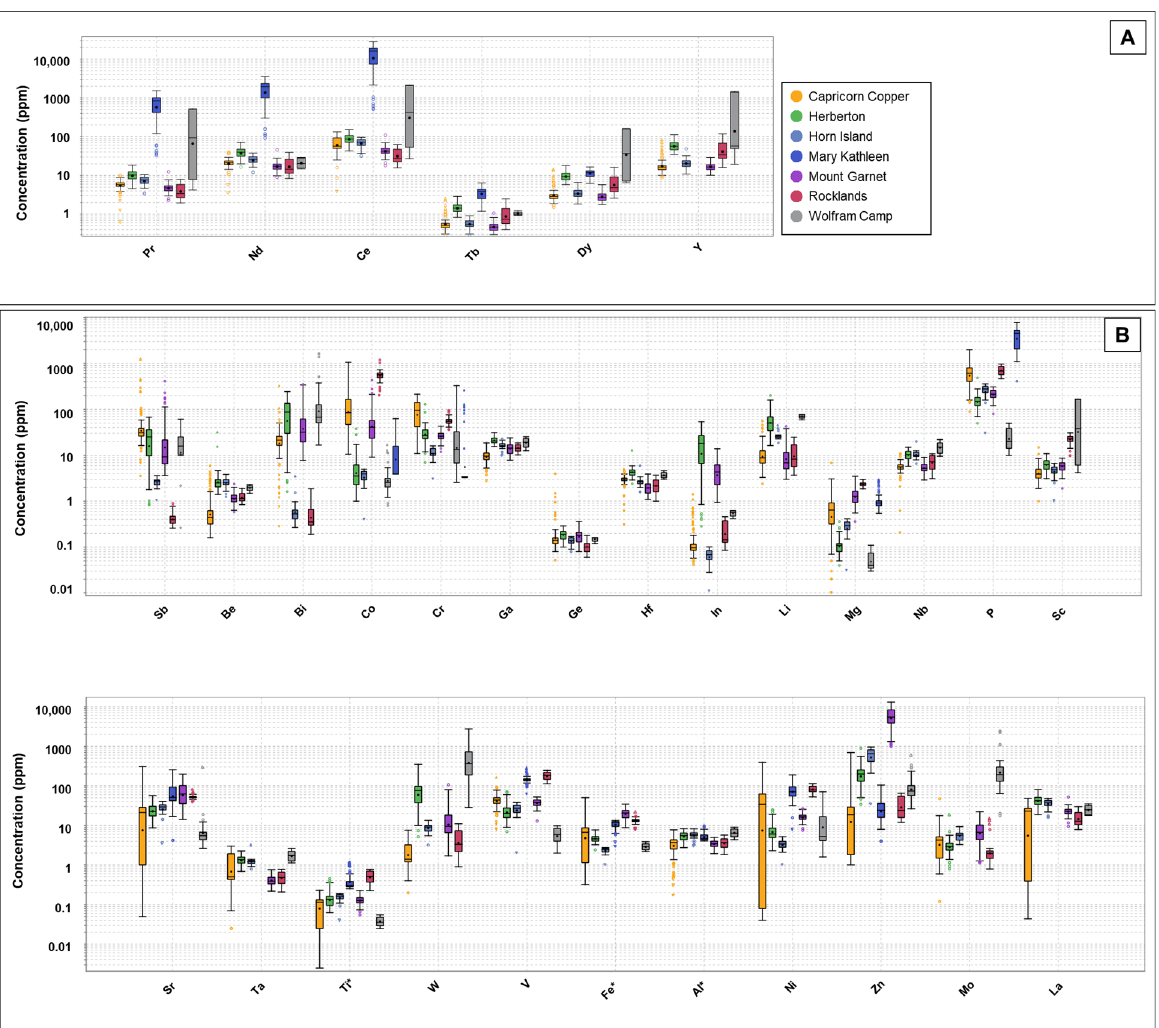
Figure 5. Tukey log-plot graph showing the concentration of the critical elements at each deposit included in Australia split in ( A ) REEs-Praseodymium, Neodymium, Cerium, Terbium, Dysprosium and Yttrium ( B ) other critical elements. All concentrations in ppm except Titanium, Iron and Aluminium displayed as %. The box is the middle 50% of data from Q1 to Q3. The outliers (circles) are in the top or bottom 5% of the data. The whiskers are the 5% and 95% values.